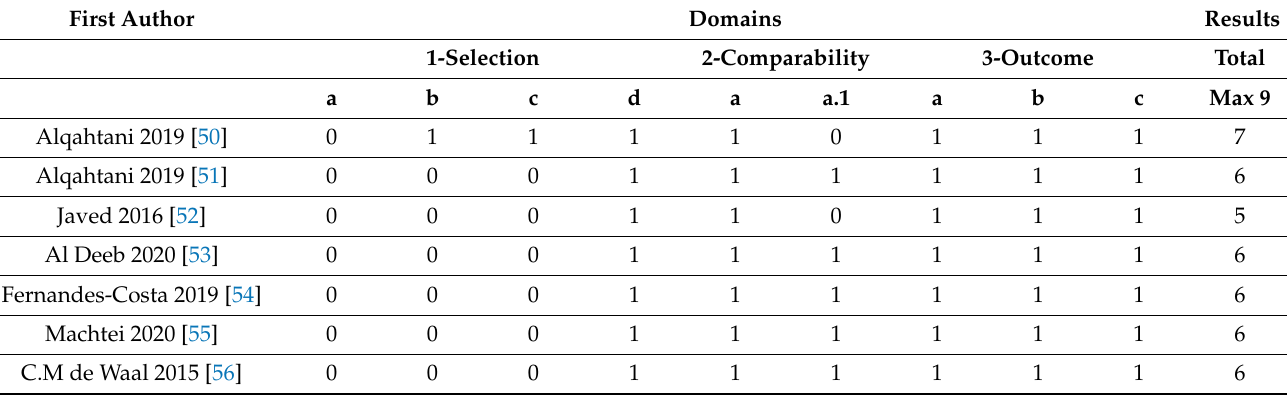
Table 3. Risk of bias in